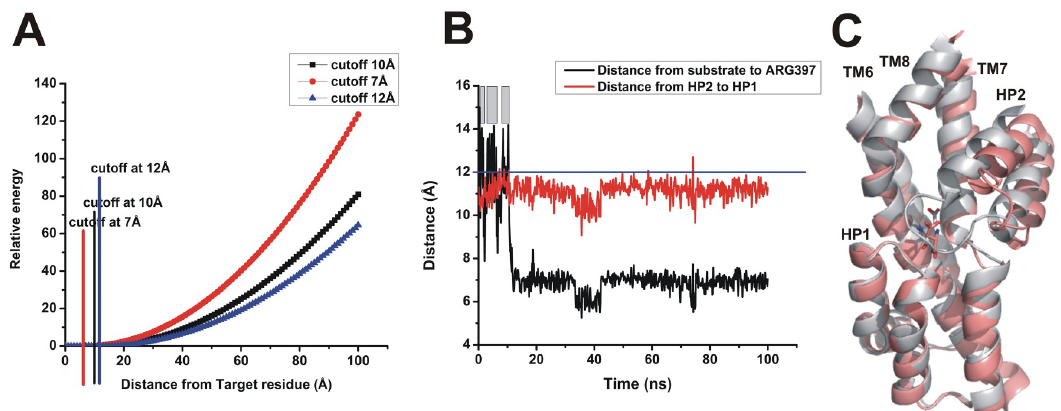
Fig 3. Flat-bottom harmonic potential to accelerate aspartate binding. (A) Illustration of the flat-bottom harmonic potential that was used with cutoff distances indicated in red (7 Å ), black (10 Å ) and blue (12 Å ). (B) Typical trajectory for the aspartate binding process. The grey bars indicate the time spent beyond the zero energy cut-off distance. (C) Structural snapshot of the final state after 100 ns simulation time, compared with the Glt crystal structure ph